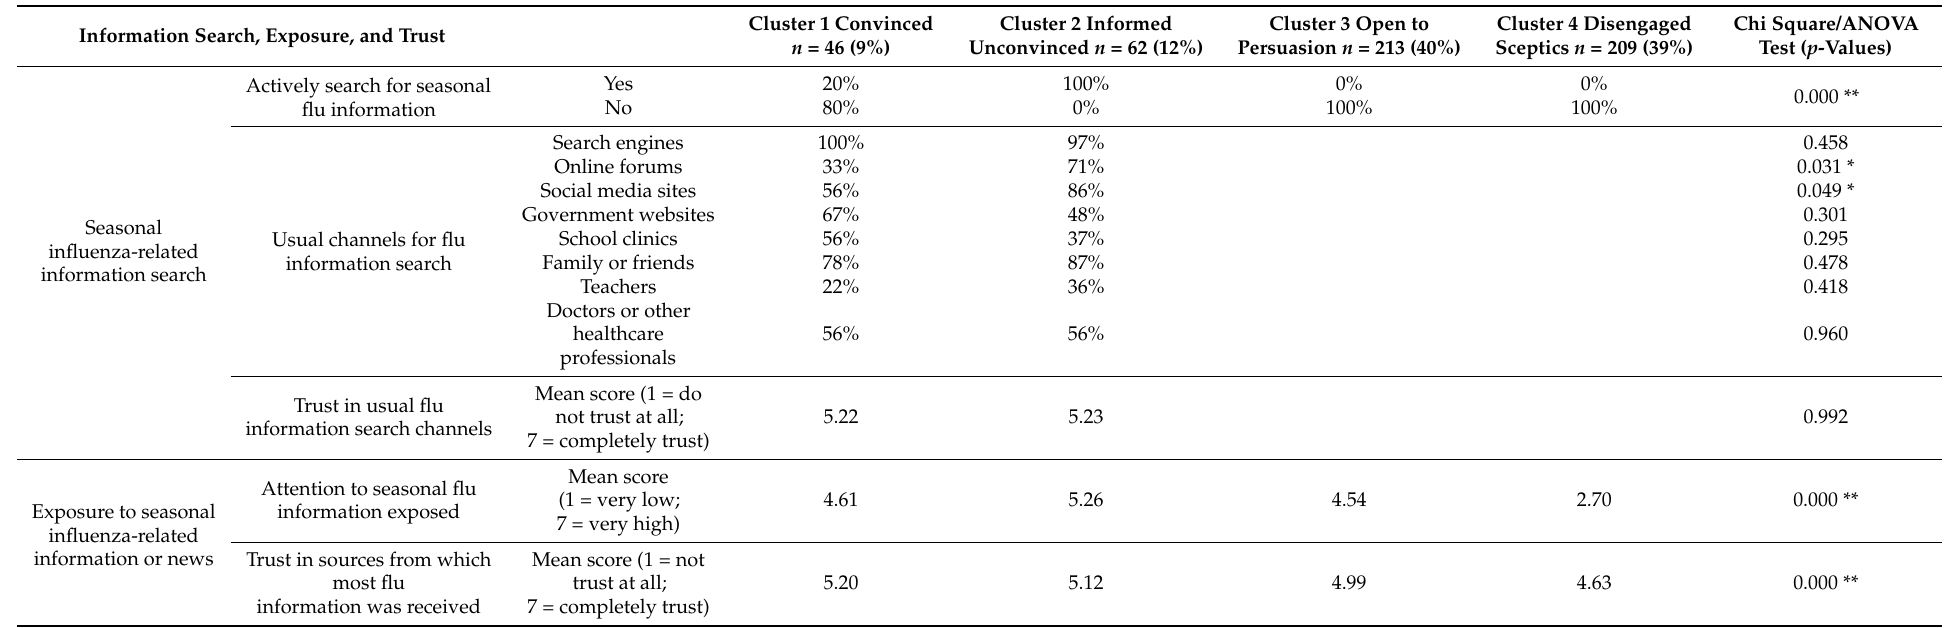
Table 6. Seasonal influenza vaccine-related information search, exposure, and trust by